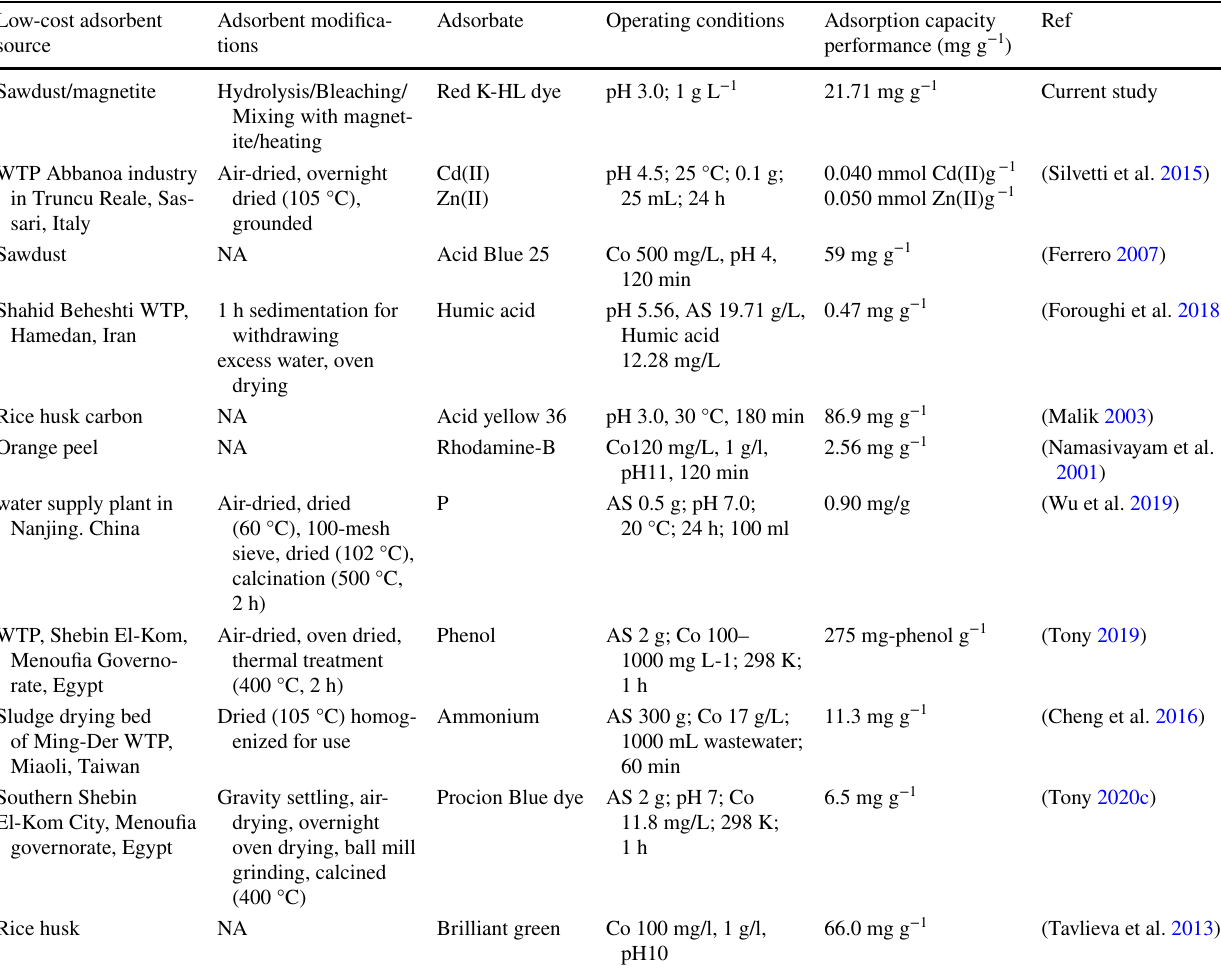
Table 4 Comparison of various low-cost adsorbents uptakes from current study and relevant in literature using various adsorbate*